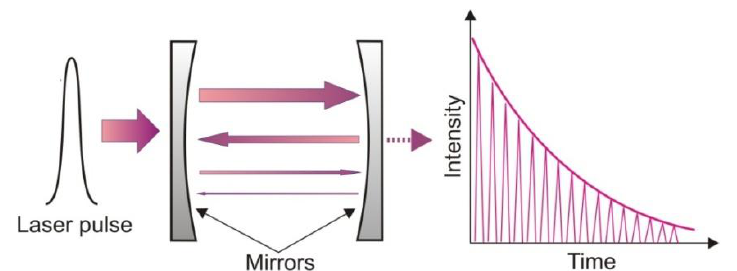
Figure 1. Cavity ring down spectroscopy idea.